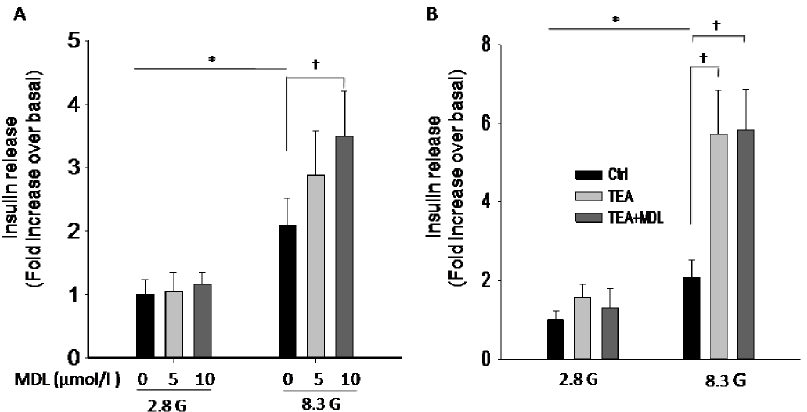
Figure 6. MDL-12,330A influences insulin secretion via K V channels rather than K ATP channels in rat pancreatic islets. All islets were preliminary incubated for 30 min in KRB solution containing 2.8 mM glucose (2.8 G), then incubated in KRB solution containing 2.8 G or 8.3 G in the presence or absence of the compounds as indicated. Insulin release from these islets was subsequently assayed and the values were normalized to basal secretion at 2.8 G. A. effects of MDL-12,330A on insulin secretion at 2.8 G (MDL 0 m M, n=6; MDL 5 m M, n=6; MDL 10 m M, n=5) and at 8.3 G condition (MDL 0 m M, n=5; MDL 5 m M, n=6; MDL 10 m M, n=5). B. effects of TEA (20 mM) on insulin secretion in the absence or presence of MDL- 12,330A (10 m M) at 2.8 G (Ctrl, n=6; TEA, n=5; TEA + MDL, n=5) and at 8.3 G condition (Ctrl, n=6; TEA, n=5; TEA + MDL, n=5). *P , 0.05, { P ,